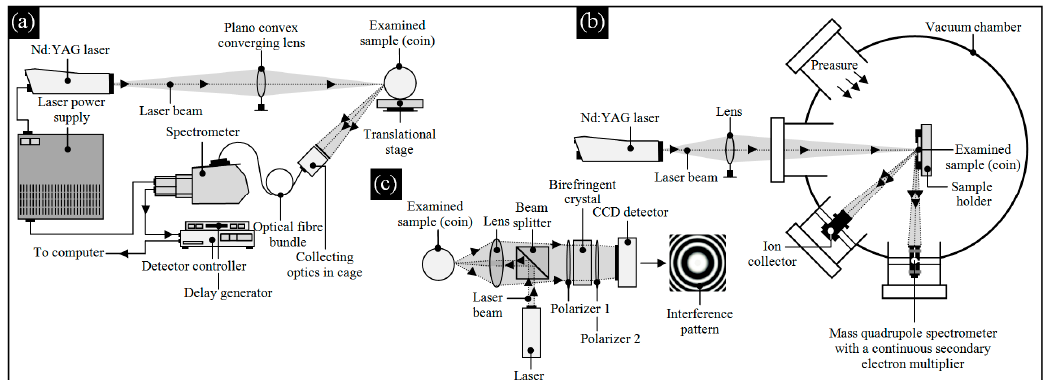
Figure 1. Selected experimental setups used for analyzing of the ancient coins: ( a ) laser-induced breakdown spectroscopy (LIMB), presented in the work of Awasthi et al. [14] (coins collected from the G.R. Sharma Memorial Museum, University of Allahabad, India, dating back to VI Cent. A.D.); ( b ) laser ablation coupled with mass quadrupole spectrometry (LAMQS), presented in the work of Torrisi et al. [8] (Mediterranean basin bronze coins, dating back to the II–X Cent. A.D.); ( c ) high-resolution laser microprofilometry using conoscopic holography (CH), presented in the work of Spagnolo et al. [43] (ancient Roman coins, dating back to the I Cent. A.D.).